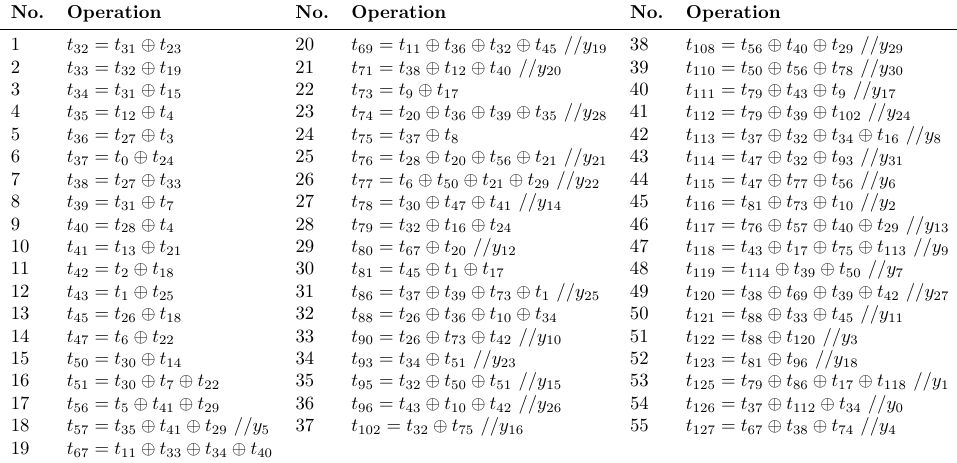
Table 6: An implementation of AES MixColumns with 243 GE for STM 130 nm library. It uses 22 XOR2 gates, 21 XOR3 gates, and 12 XOR4 gates. t 0 , t 1 , . . . , t 31 are the input values. The output values are y 0 , y 1 , . . . , y 31